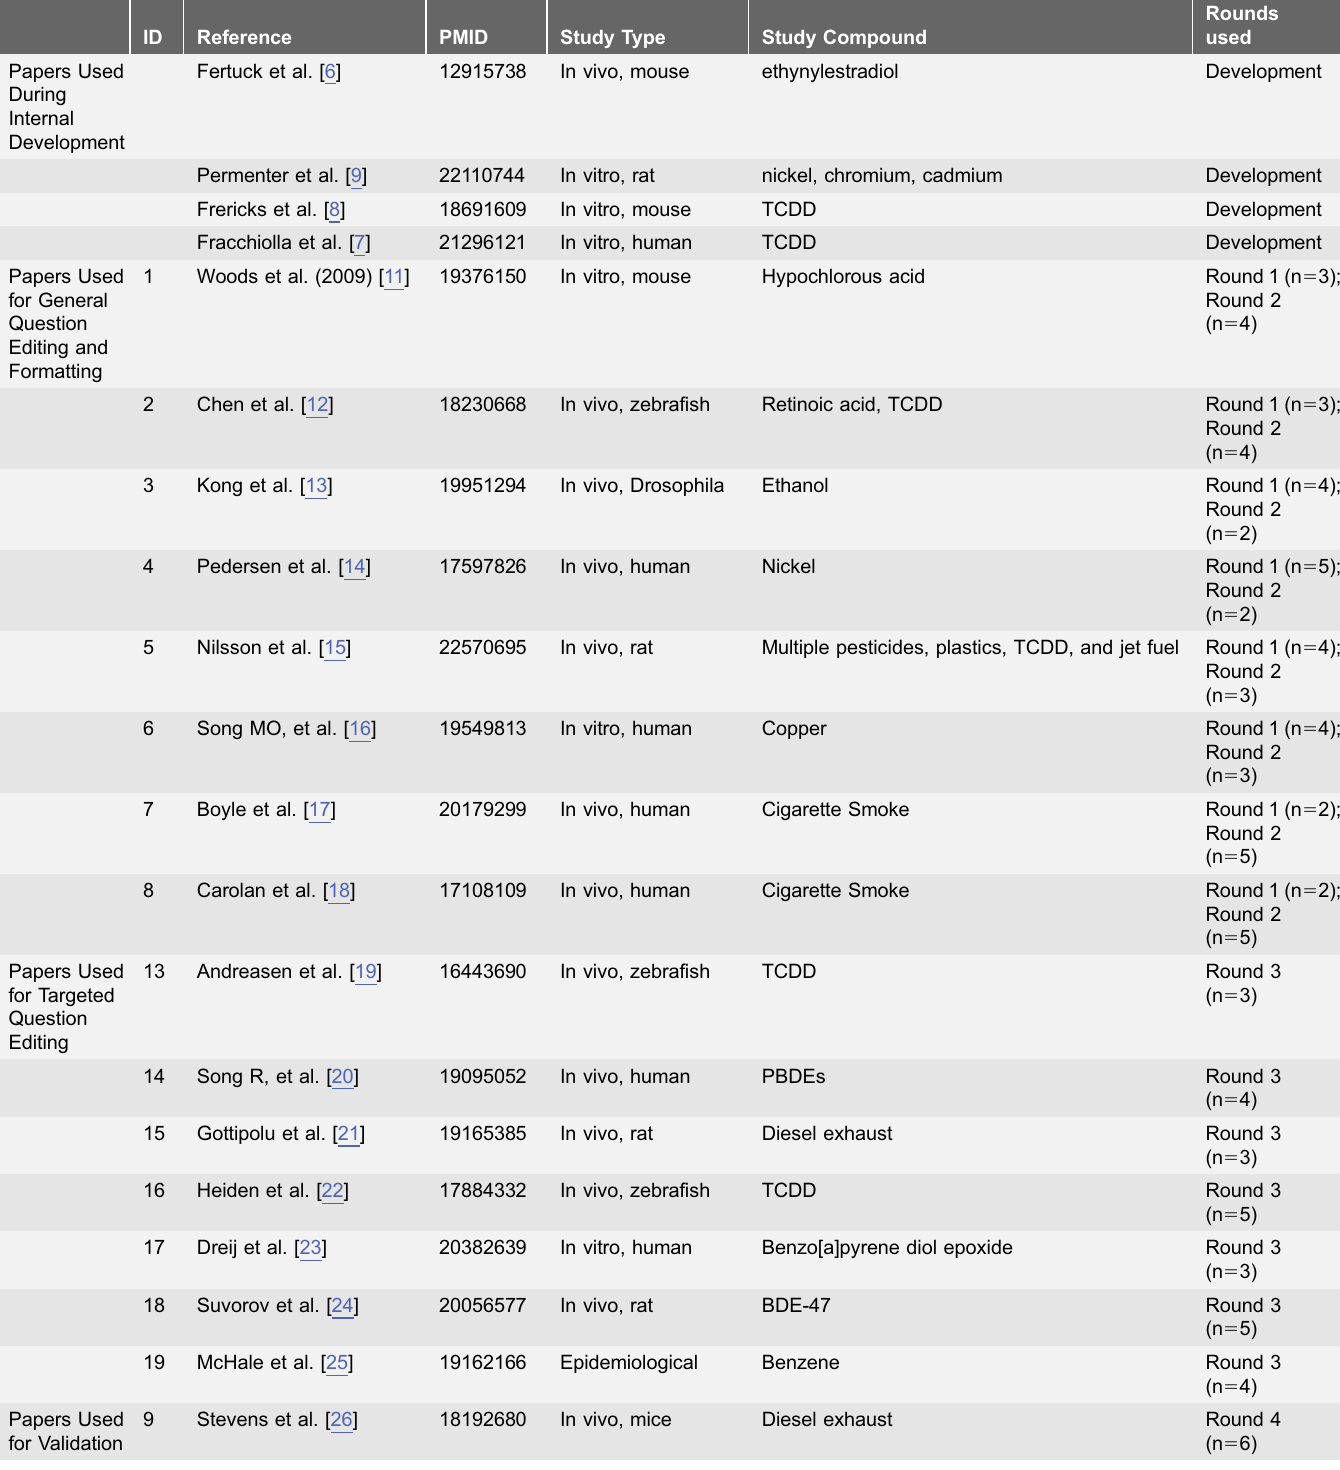
Table 2. The papers used to develop and test the SOAR tool. The first four were used only during internal development of the